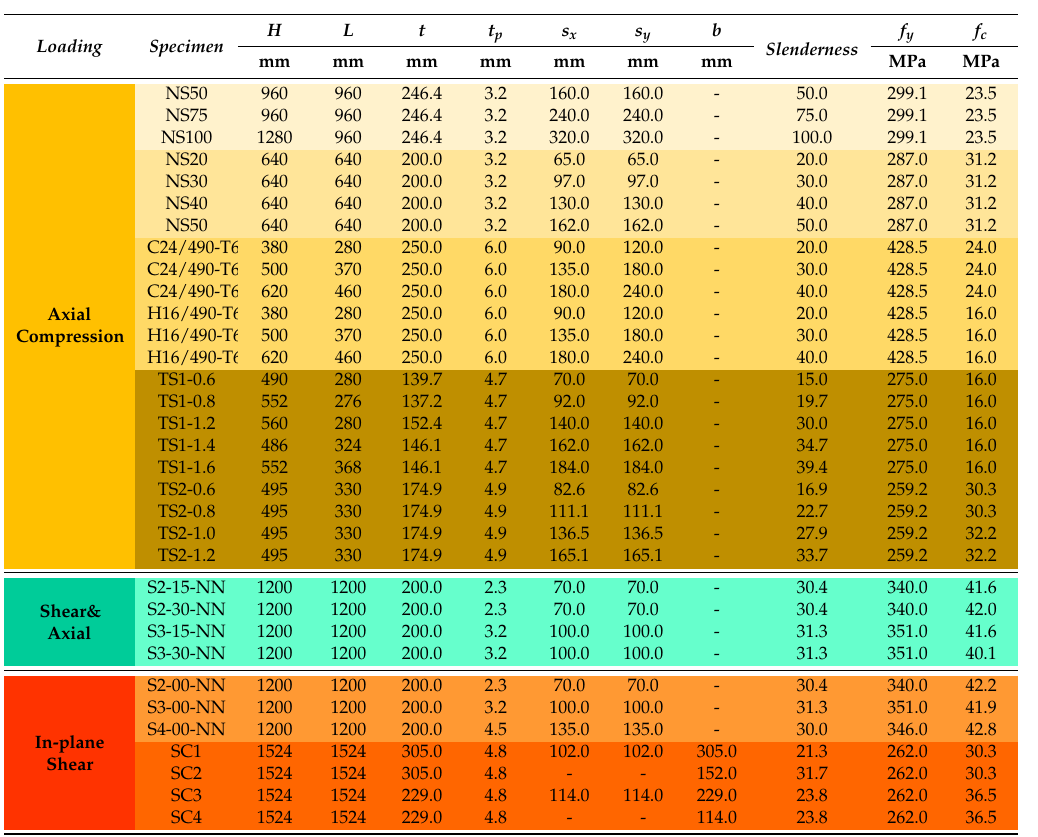
Table 1. Experimental Database—Details of tested